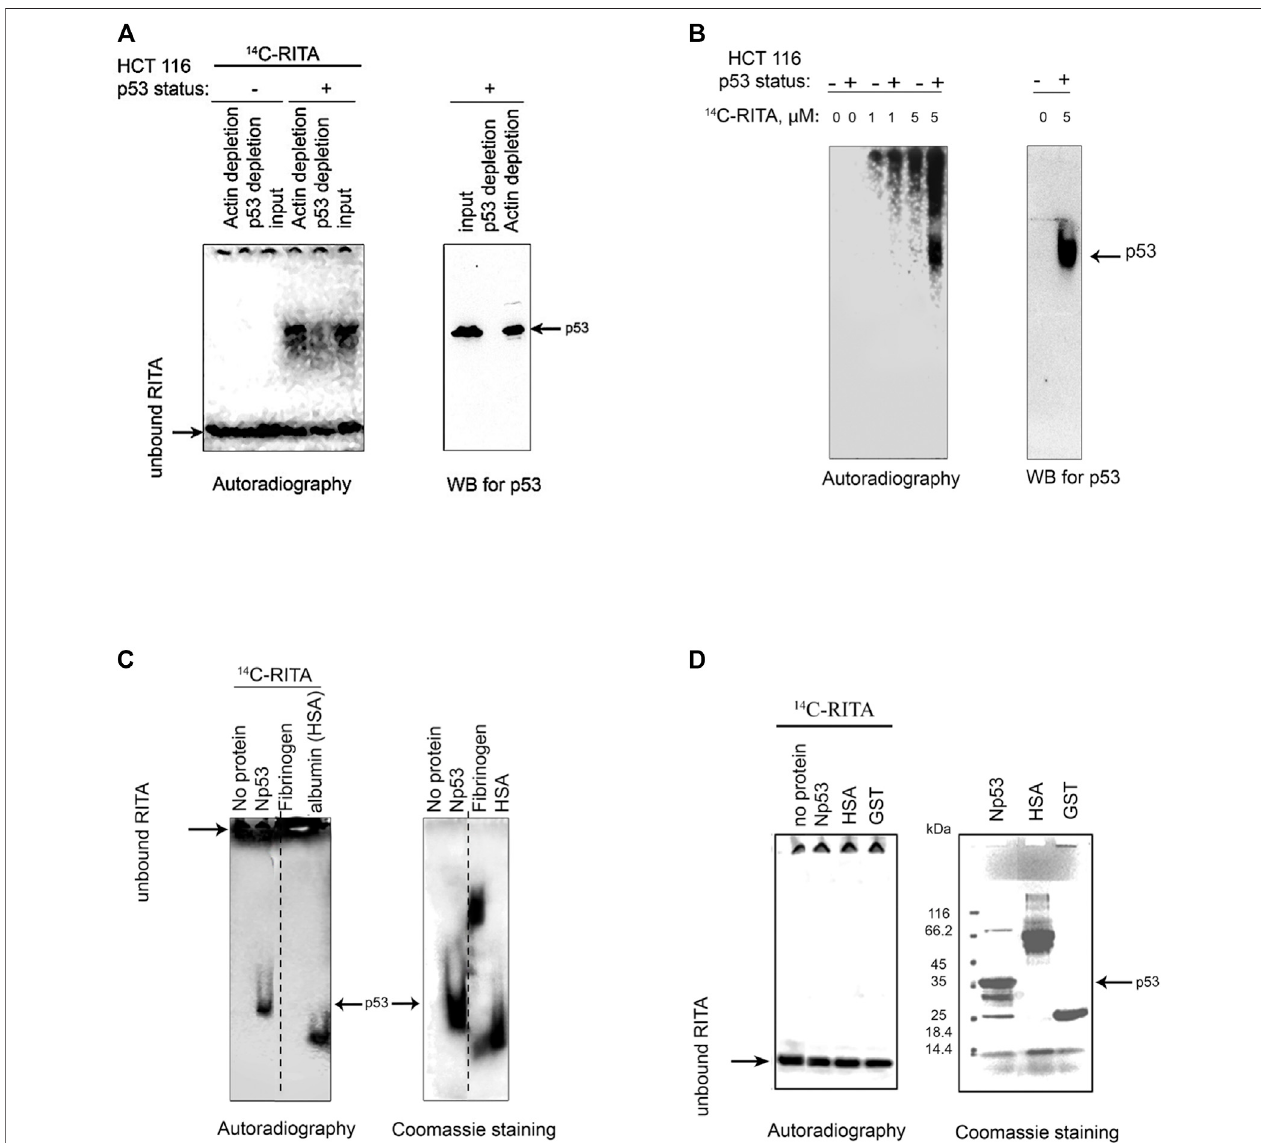
FIGURE 1 | RITA binds to p53 in cancer cells and in vitro . (A) [ 14 C]-RITA/protein complexes were analyzed in cancer cells treated with 5 μ M [ 14 C]-RITA for 12 h to enable suf fi cient accumulation of RITA. Cell lysates of HCT 116 or HCT 116 TP53 − / − cells were separated in 10% SDS-PAGE under mild denaturing conditions (snap denaturation). The position of [ 14 C]-RITA was visualized by autoradiography. p53 was detected by immunoblotting before and after immunodepletion with DO-1 antibody (right panel). Shown is a representative data of three independent experiments. (B) A small-molecule band shift assay in gradient polyacrylamide gel run undernon-denaturing conditionsin4and 6%TBEgel showed that[ 14 C]-RITA bindstop53inHCT 116cells[ 14 C]-RITAandp53 weredetected asinFigure A. (C) [ 14 C]- RITA binds to GST-Np53(2 – 65) fusion protein, and human serum albumin (HSA) but not to fi brinogen as detected by a small-molecule band shift assay in 6% TBE gel using 2:1 M excess of RITA. Dotted line indicates where the gel was cut. (D) Upon standard denaturing conditions [ 14 C]-RITA/p53 and [ 14 C]-RITA/HSA complexes are